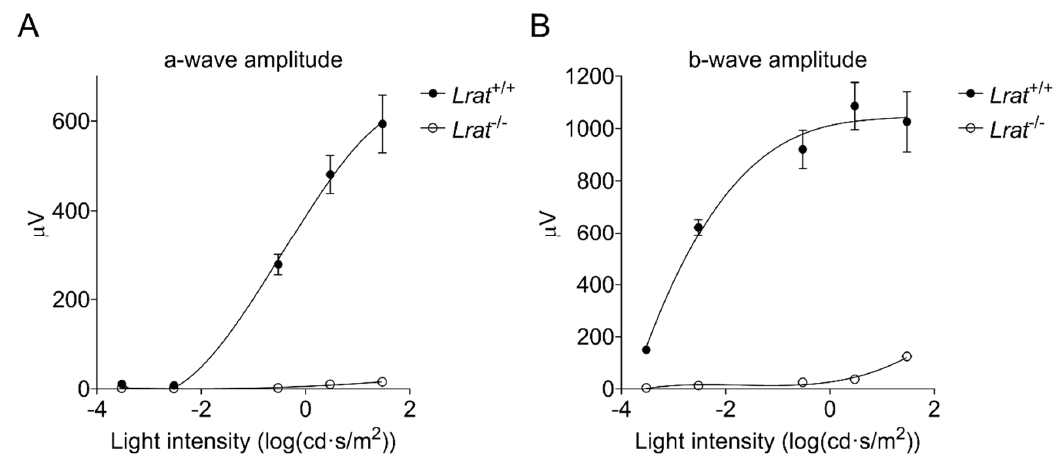
Figure 8. ERG responses of Lrat +/+ ( n = 6) (black circles) and Lrat − / − ( n = 6) (white circles) animals at 2 weeks of age after a single light stimulus. Averaged a-wave ( A ) and b-wave ( B ) amplitudes per experimental group plotted against increasing light intensity. B-wave responses were extremely decreased, and a-wave responses were almost completely absent in Lrat − / − animals, indicating that these animals are blind from 2 weeks of age onwards.